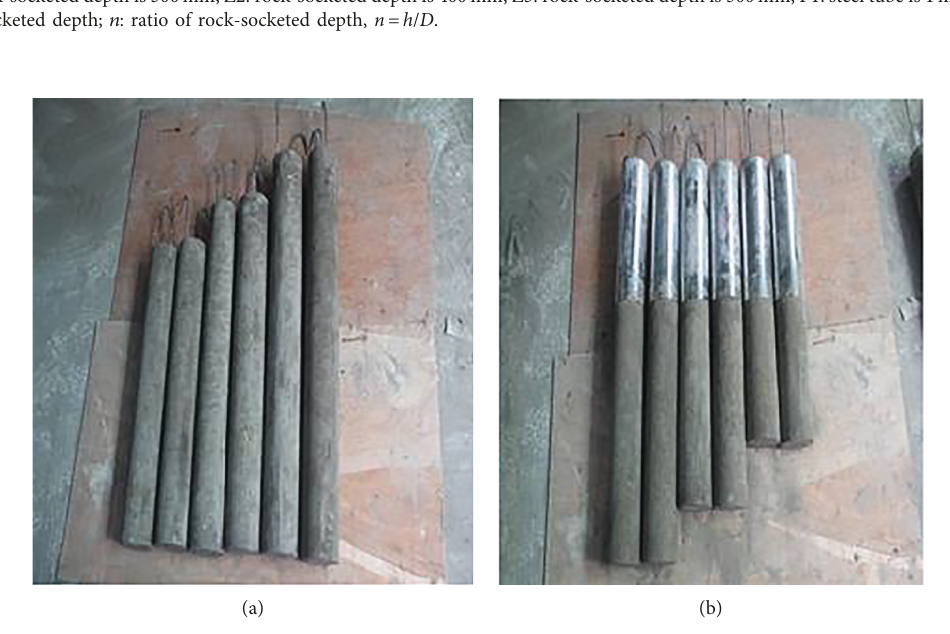
Figure 3: Properties of the materials. (a) General prefabricated piles. (b) Steel tube prefabricated